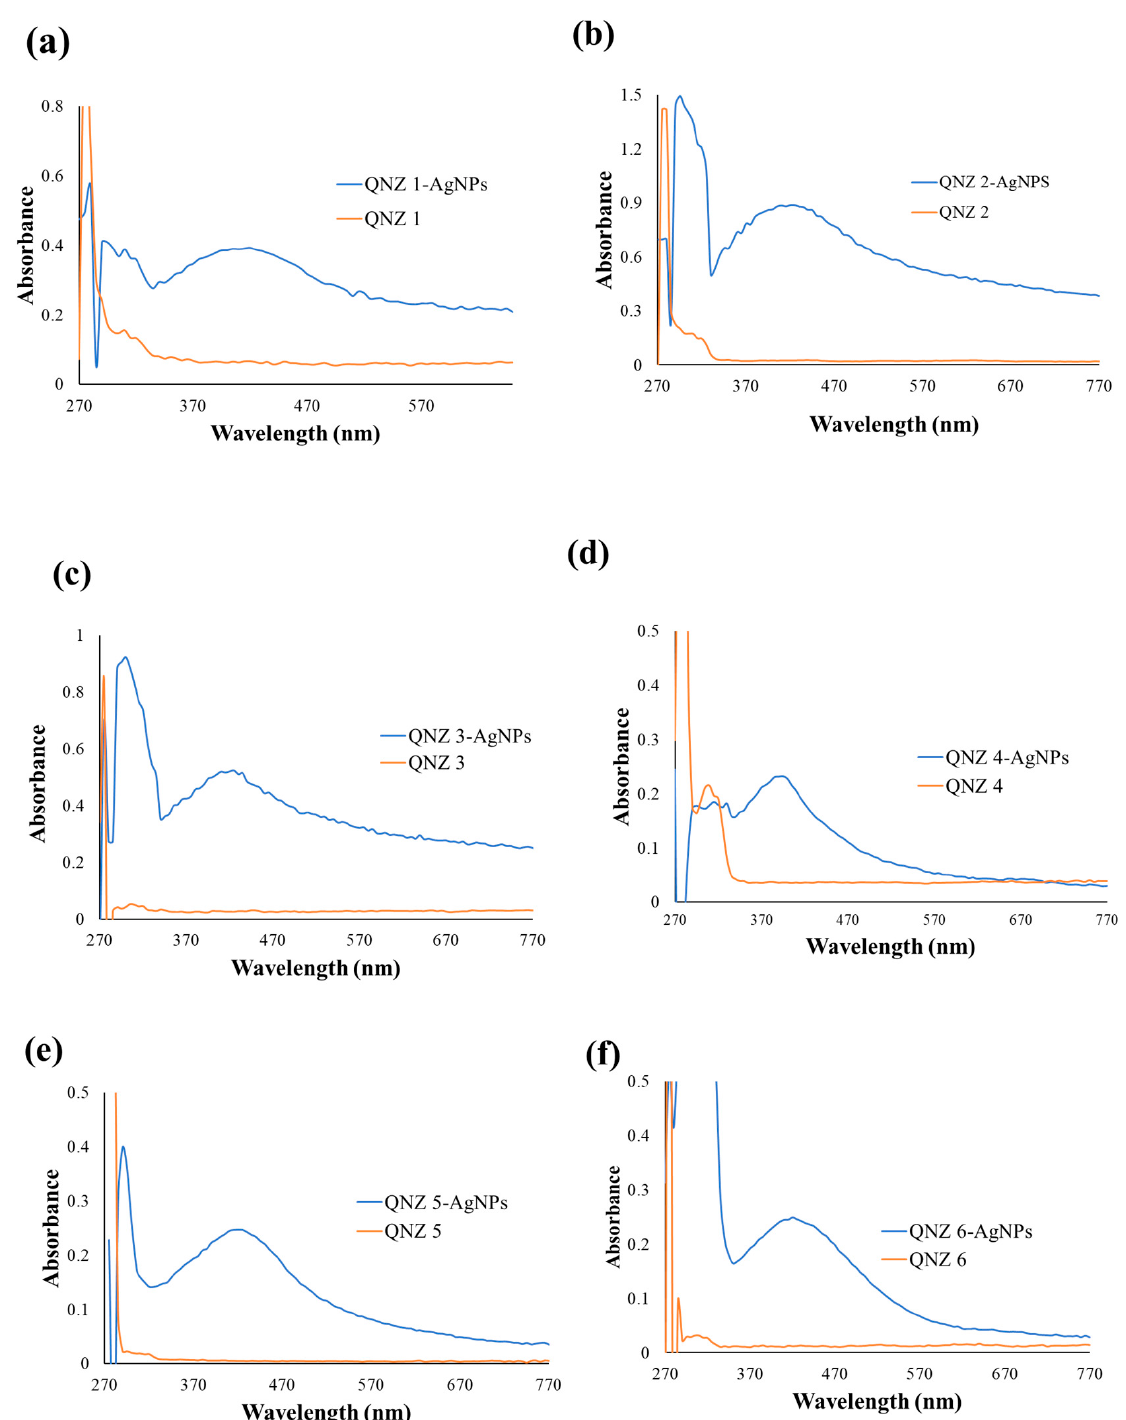
Figure 1. UV-vis spectrum of Quinazolinone (QNZ) 1, QNZ 1-AgNPs ( a ). QNZ 2, QNZ 2-AgNPs ( b ). QNZ 3, QNZ 3-AgNPs ( c ). QNZ 4, QNZ 4-AgNPs ( d ). QNZ 5, QNZ 5-AgNPs ( e ). QNZ 6, QNZ 6-AgNPs ( f ). The spectrum of each QNZ is represented in red line and in blue line after conjugations with silver, the nanoconjugate showed characteristic surface plasmon resonance band at 450 nm.